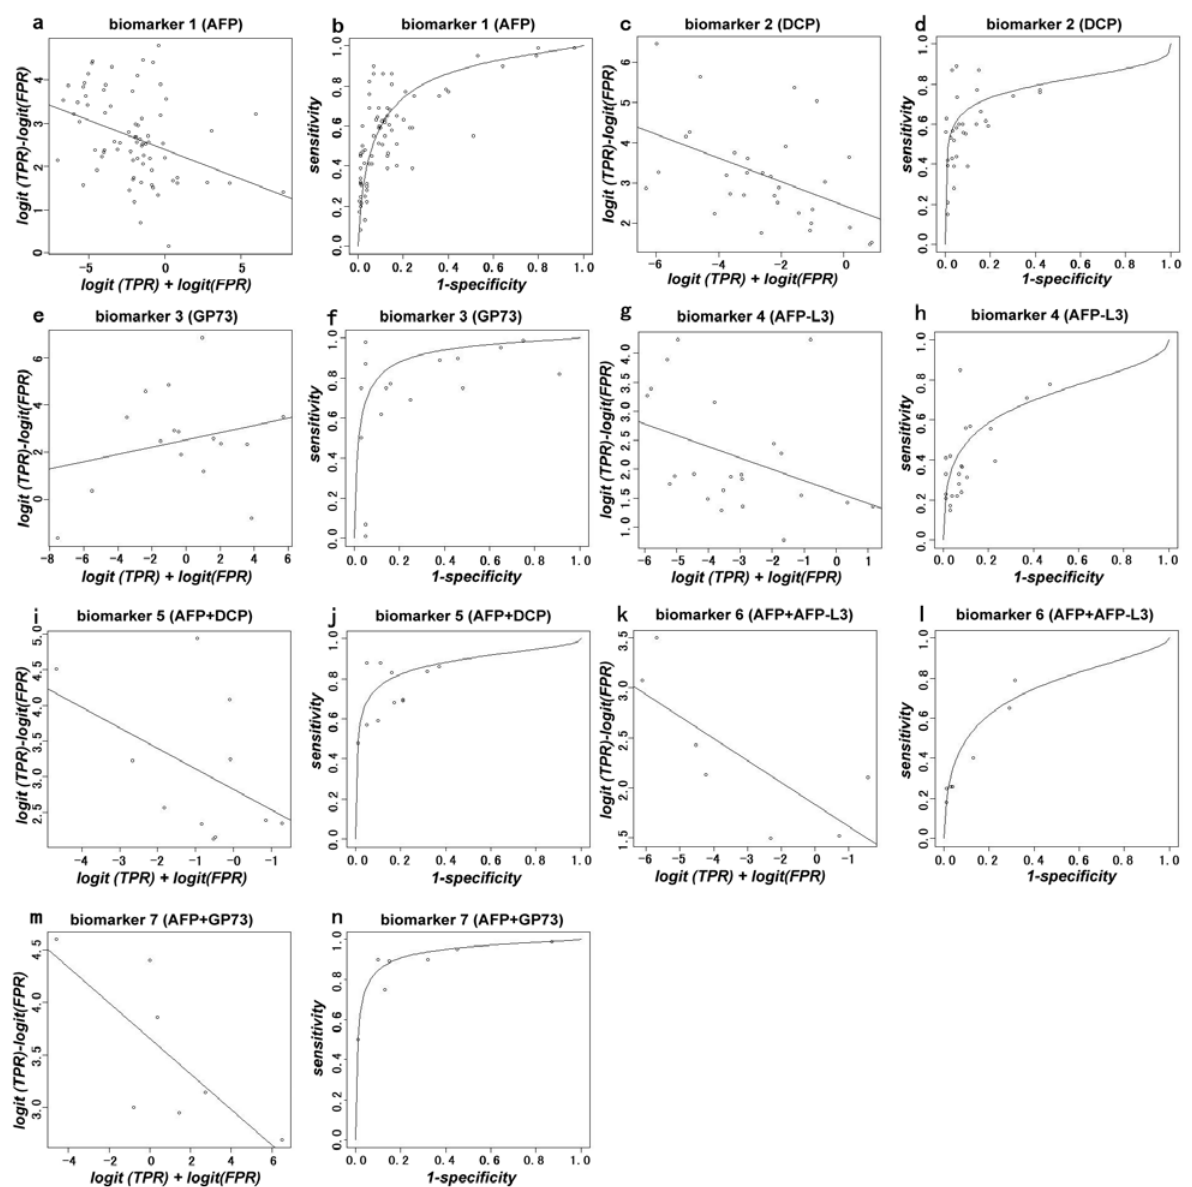
Figure 2. Plots for calculating the area under the curve (AUC) and D (log odds ratio) against S (implicit threshold) for biomarker 1 to biomarker 7 . The S -value represents the positive rate of the biomarker for detecting HCC. S = logit (TPR) + logit (FPR), where TPR is the true positive rate (sensitivity) and FPR is the false positive rate (1-specificity) for AFP. D represents the ability of distinguishing HCC and the